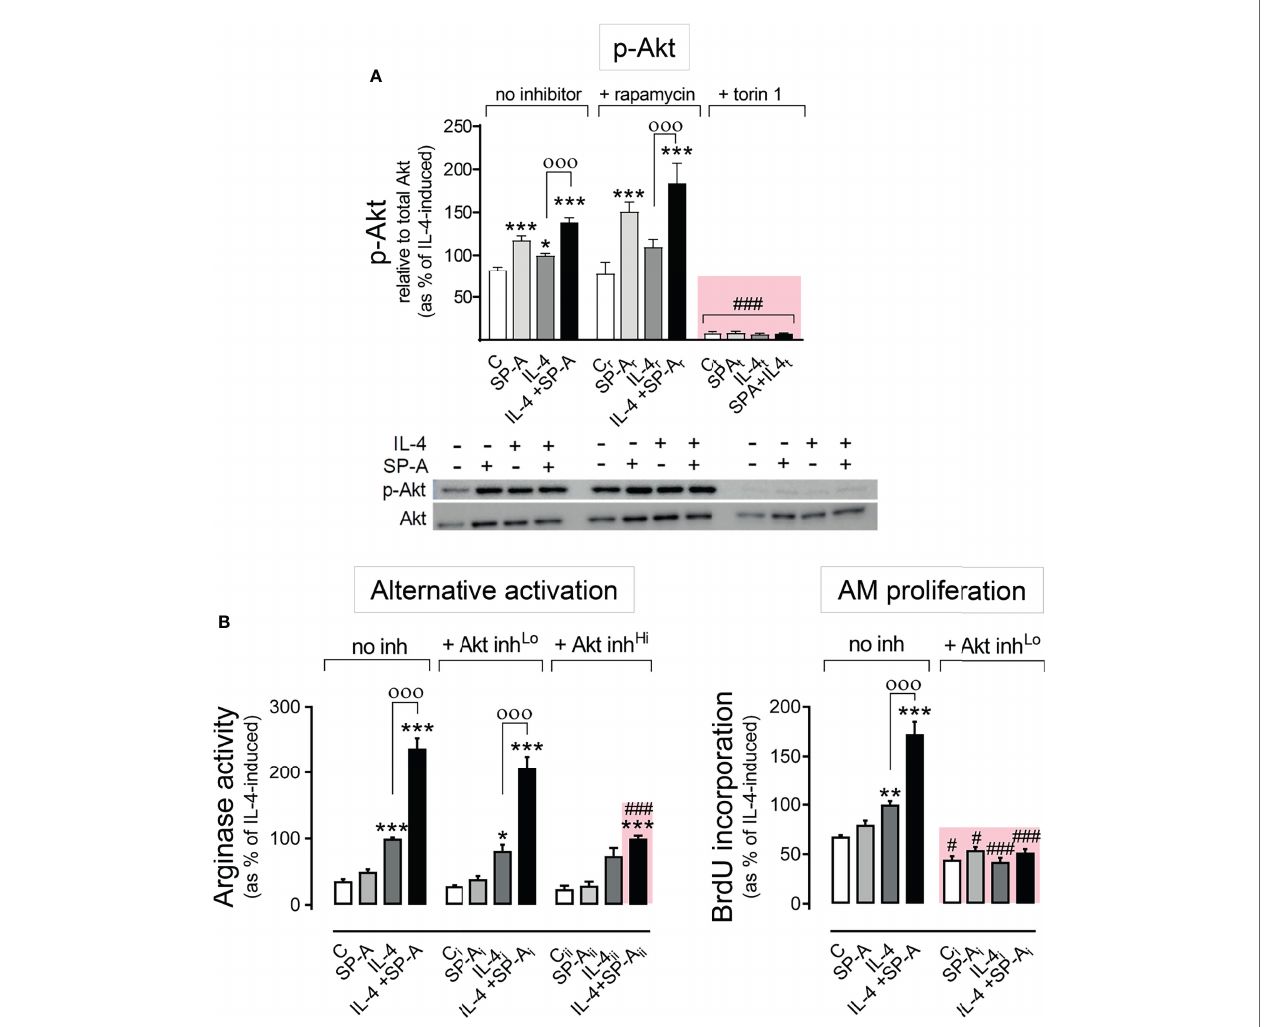
FIGURE 3 | SP-A and IL-4 induce Akt activation to enhance alternative activation and proliferation of AMs. (A) Puri fi ed rat AMs were pre-treated with 20 nM rapamycin, 100 nM torin 1, or vehicle for one hour. Cells were then stimulated with or without IL-4 (1 m g/ml) in the presence or absence of SP-A (100 m g/ml) 30 minutes, then Western blot for quanti fi cation of p-Akt (Ser473) relative to total Akt was performed. A representative Western blot image is shown below the graph. In (B) arginase activity and BrdU incorporation were measured in puri fi ed rat AMs pretreated with 25 nM (Lo), 100 nM (Hi) Akt inhibitor VIII, or vehicle for two hours, and then stimulated with or without IL-4 (1 m g/ml) and/or SP-A (100 m g/ml). The results are presented as means (± SEM) from three different cell cultures with at least three biological replicates. ANOVA followed by the Bonferroni multiple-comparison test was used. * p < 0.05, ** p < 0.01, and *** p < 0.001 when compared with untreated macrophages. ооо p < 0.001 when SP-A+IL-4-treated macrophages were compared with IL-4-treated macrophages. # p < 0.05 and ### p < 0.001 when the effect of any inhibitor (Akt inhibitor VIII or torin1) is compared with the same sample without